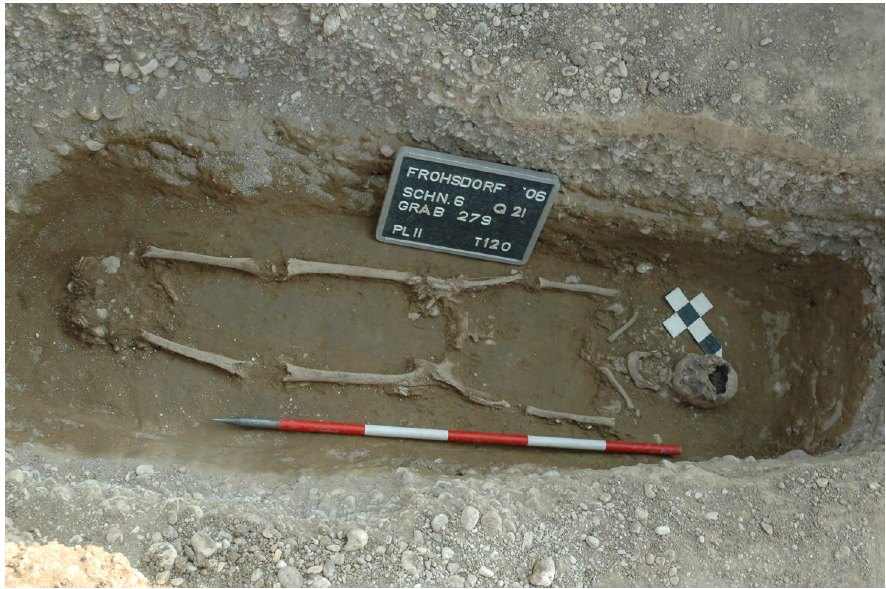
Figure 1: Grave 279 with rolled off skull (photo: Johann Rudorfer)